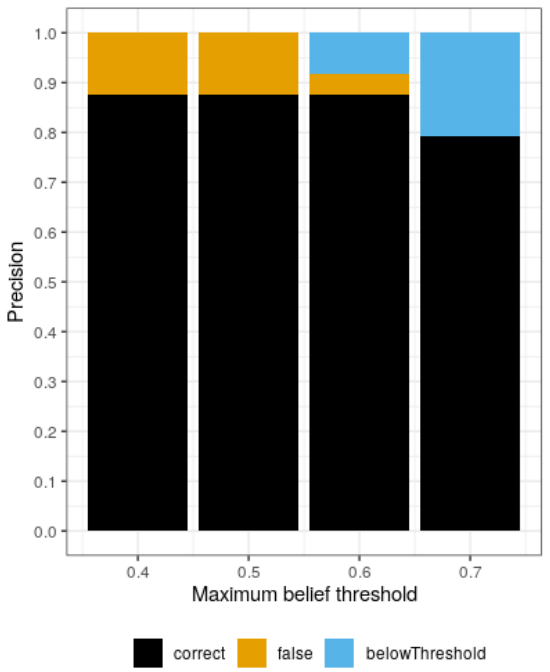
Figure 5. Results of track clustering with identifying sensor areas on living lab data with Constrained Evidential C-Means and filtering over maximum normalized beliefs